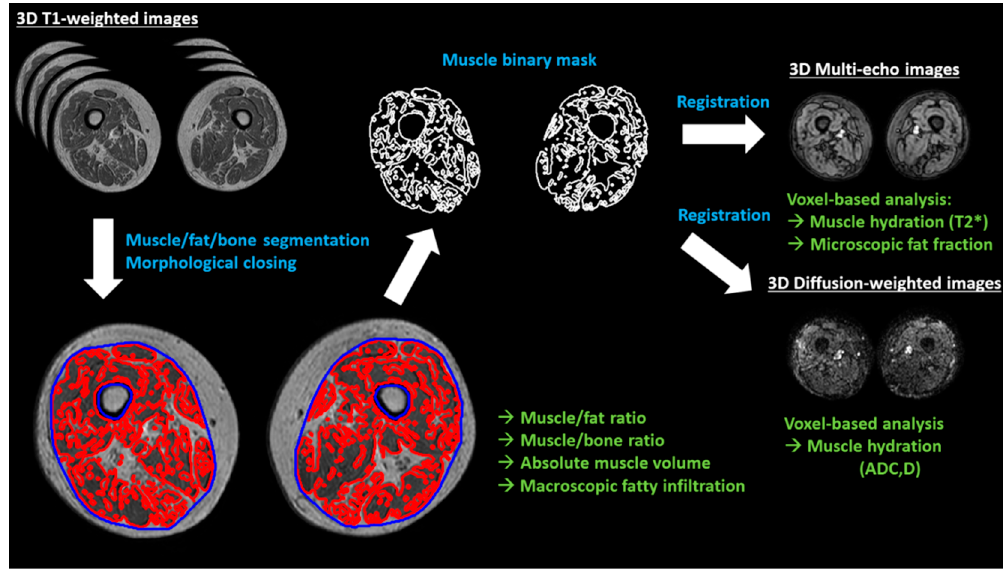
Figure 1. Summary of the image analysis workflow. Muscle, fat, and bone are segmented from the T1 ‐ weighted images using differences in image intensities. The muscle binary mask is then closed to calculate the macroscopic fatty infiltration (relative volume of fat enclosed in the muscle volume, excluding bone volume). Binary volumetric masks of the muscle are spatially registered to the rest of MR images (multi ‐ echo and diffusion ‐ weighted), obtaining microscopic fat infiltration values (fat fraction) and hydration measurements (T2*, ADC (apparent diffusion coefficient) and D (diffusion)) on a voxel basis. White text indicates MRI sequences, blue indicates image analysis processes and green is for imaging biomarkers.